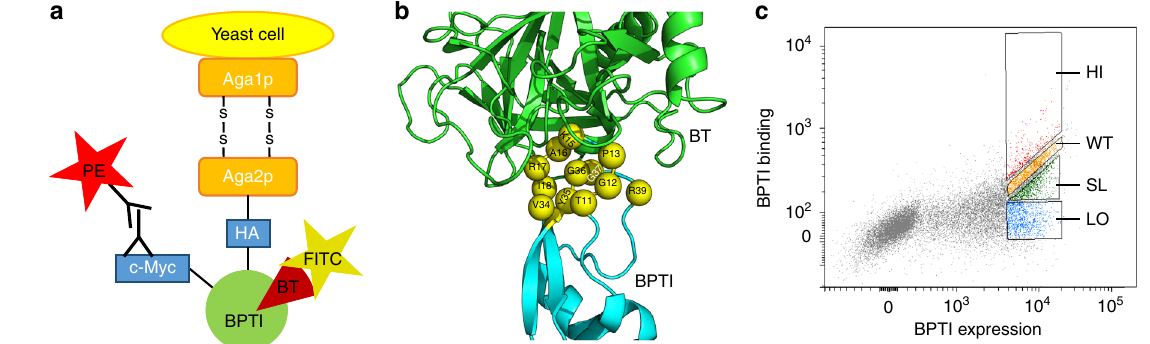
Fig. 1 Yeast surface display setup. a Yeast surface display construct with BPTI displayed on the surface of yeast cells b Construction of the BPTI single mutant library. Structure of the BT/BPTI complex is shown from PDB 3OTJ. BT is colored in green, BPTI is colored in cyan and the BPTI binding interface positions are shown as spheres, labeled and colored in yellow. c FACS data showing sorting of four different populations of the BT/BPTI complex. The PE signal monitoring BPTI expression is shown on the x-axis and the FITC signal monitoring binding between fl uorescently labeled BT and BPTI variants expressed on the yeast surface is shown on the y -axis. The uppermost sorting gate HI represents all mutants with af fi nity higher than WT. The second uppermost gate WT represents all mutants with an af fi nity similar to BPTI WT . The third gate SL represents all mutants with an af fi nity slightly lower than WT and the lowest gate LO represents all mutants with an af fi nity much lower than WT. BT concentration was 5 nM in